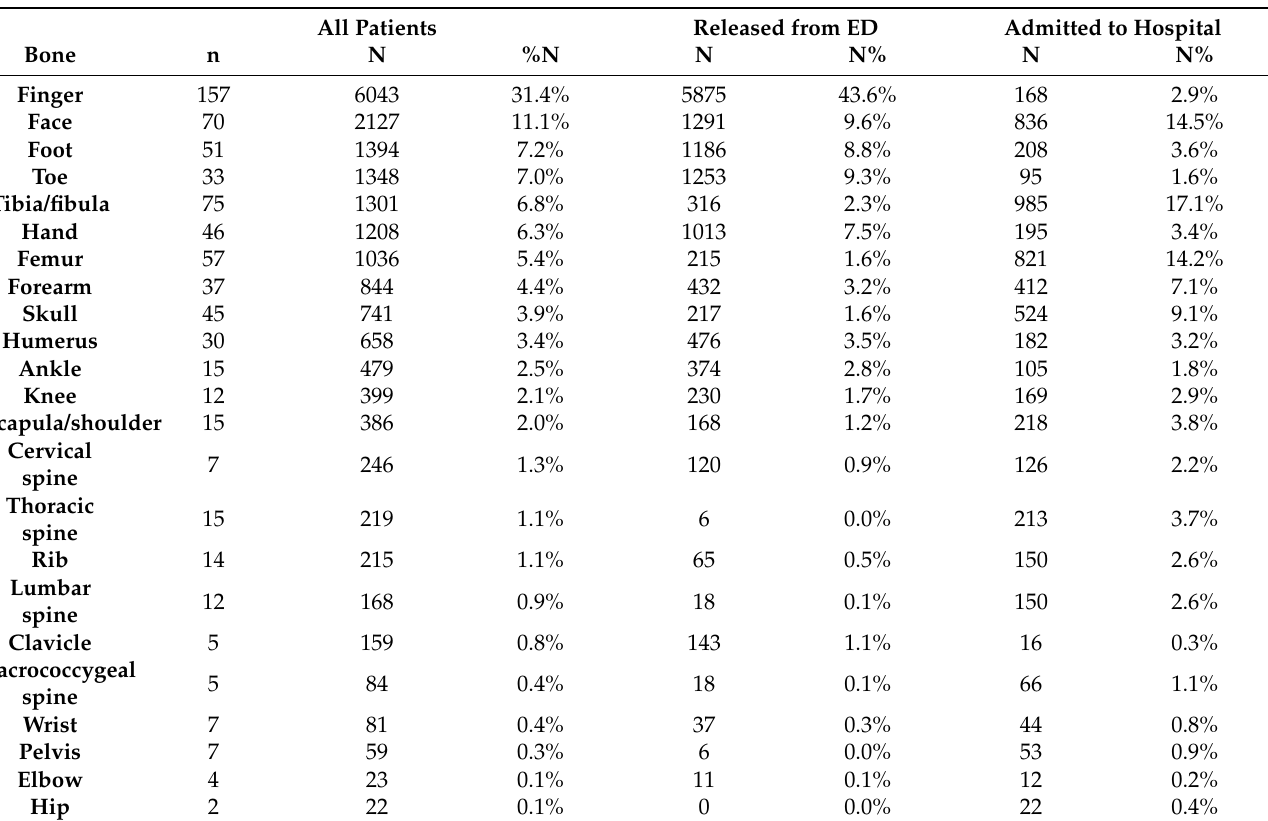
Table 2. Anatomic distribution of 19,370 fractures in 19,033